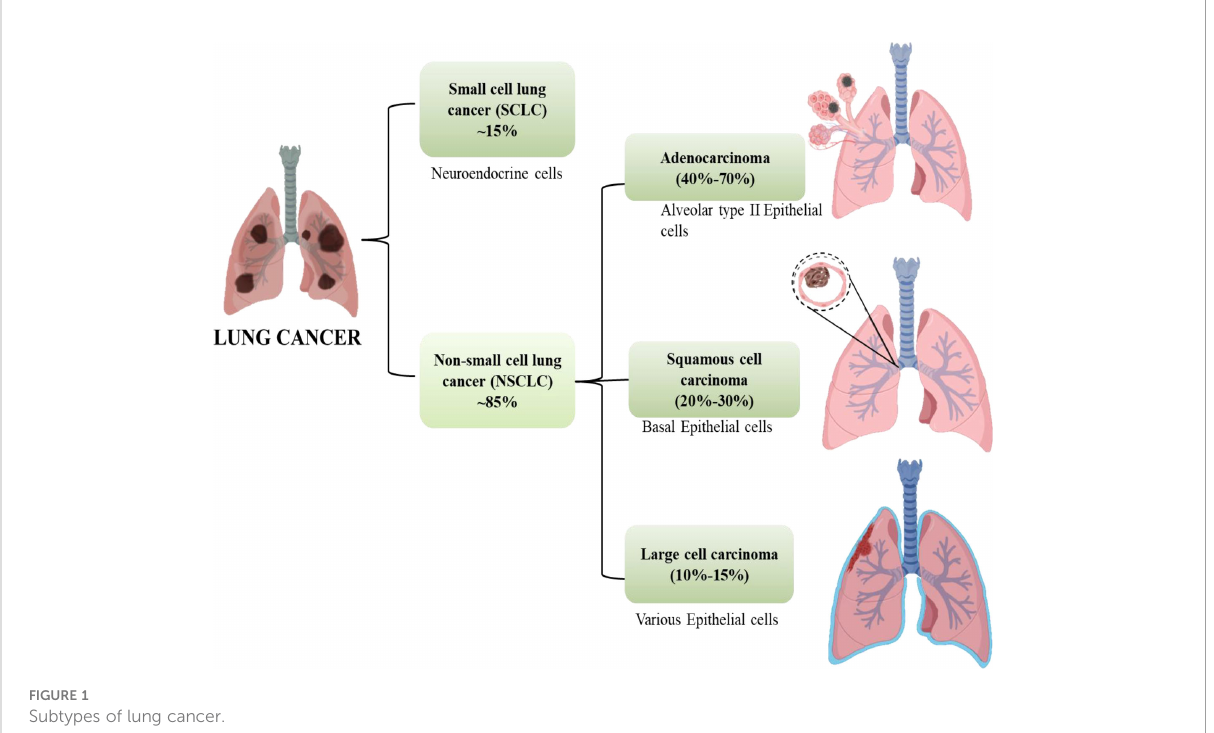
FIGURE 1 Subtypes of lung